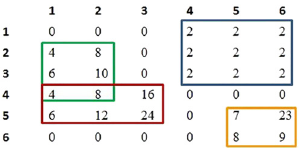
Figure 1: Four biclusters from a simplified expression matrix. The blue bicluster is a bicluster with constant values . The green one is a bicluster with additive coherent values . The red one is a bicluster with multiplicative coherent values . And the orange one is a bicluster with coherent evolution by columns only.